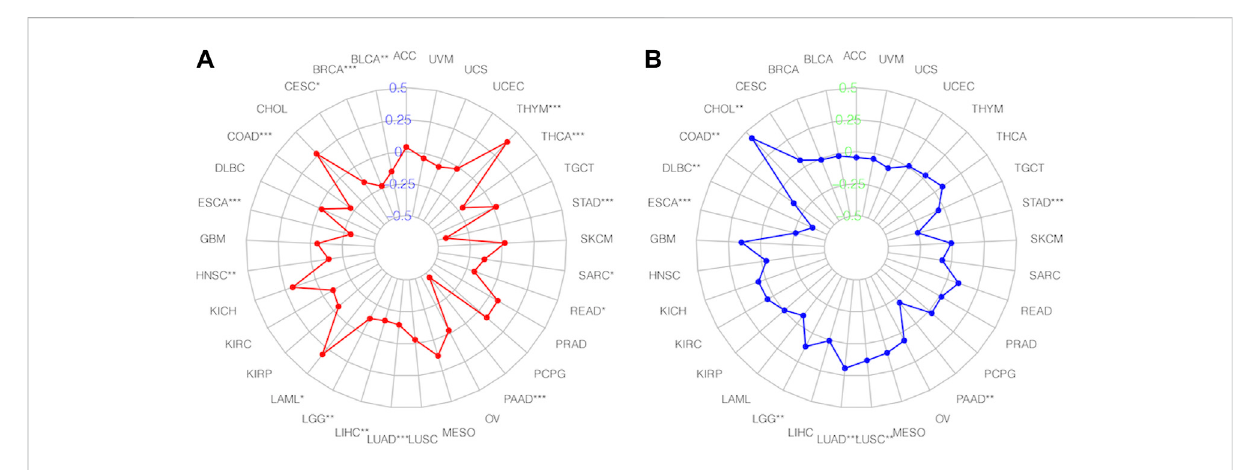
FIGURE 10 Relationships between SNHG14 gene expression and TMB (A) , MSI, (B) in different types of